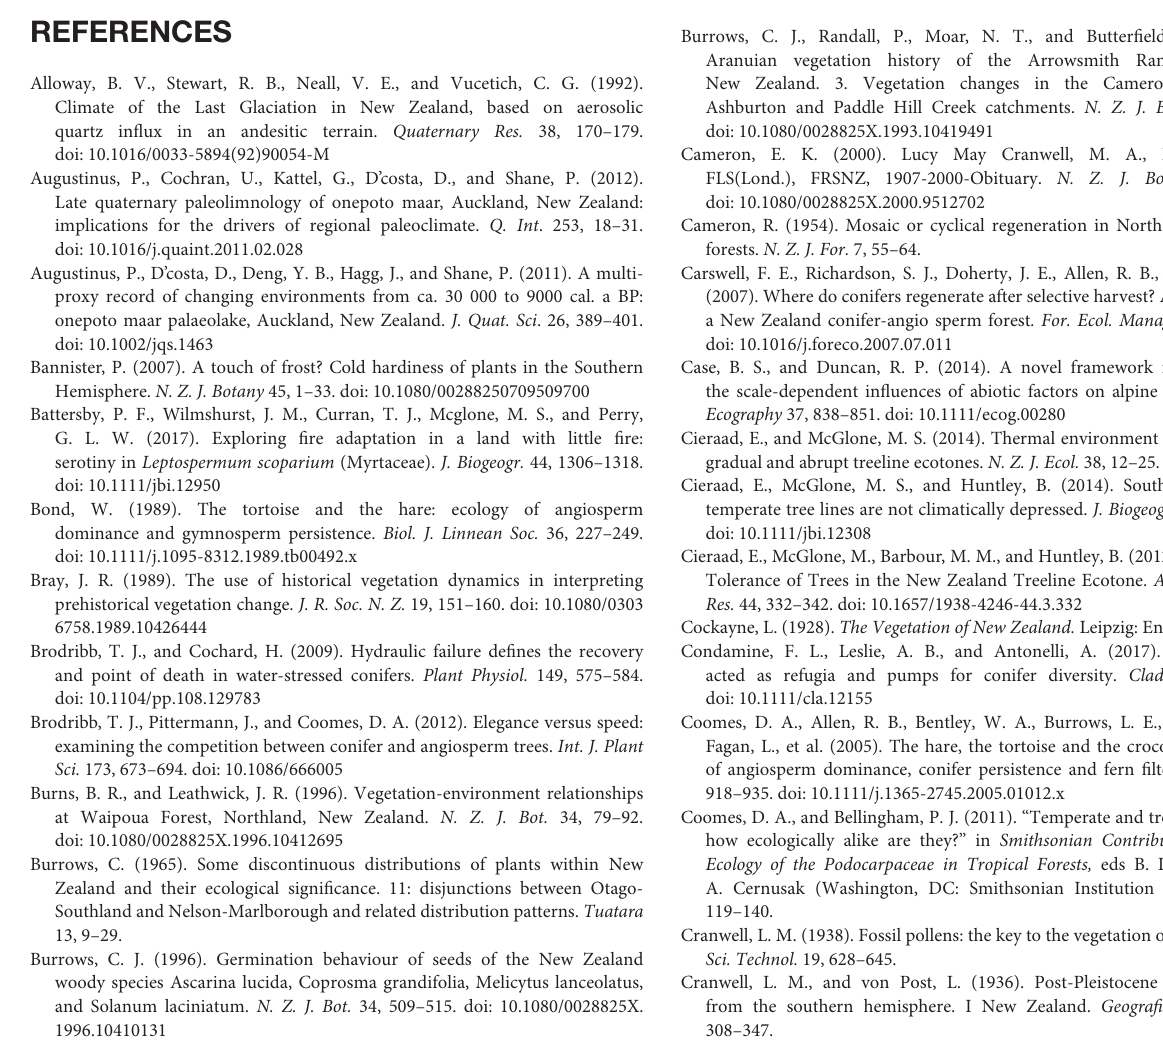
drafting Figure 2 . We acknowledge the use of data drawn from the Natural Forest plot data collected between January 2002 and March 2007 by the LUCAS programme for the Ministry for the